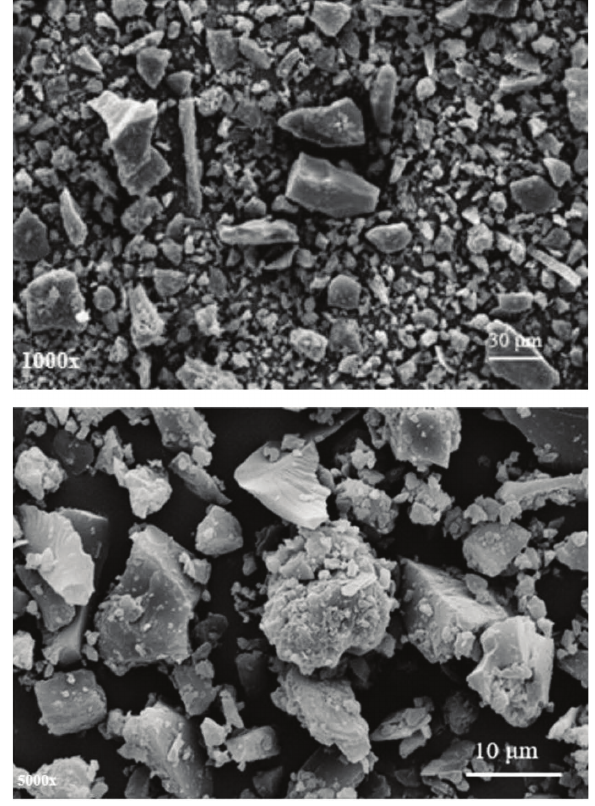
Fig. 1 – SEM micrographs showing the external morphology of the raw coal (1000 and 5000x